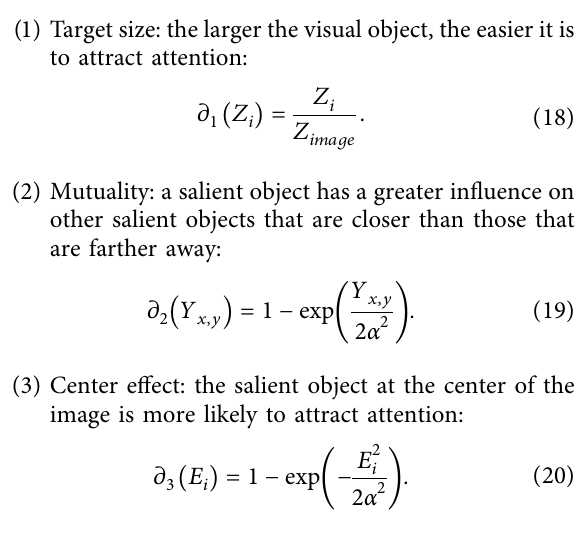
Figure 5 is a diagram of the visual focus shifting process.